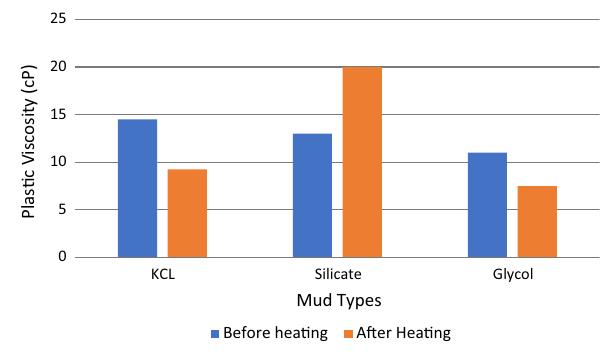
Fig. 2 Plastic viscosity for different drilling fluids